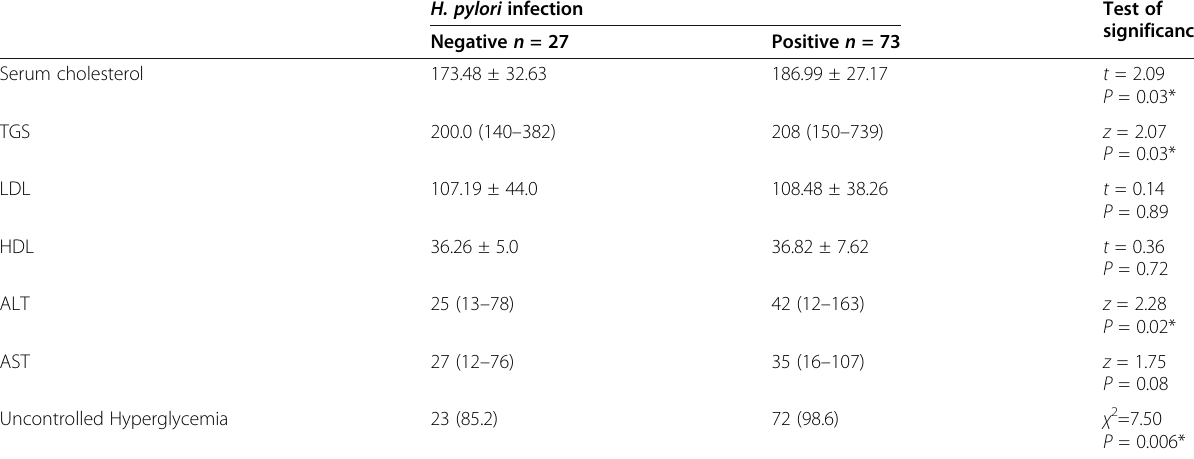
Table 7 Lipid profile among patients with HP positive versus HP negative in MET S with NAFLD group H. pylori